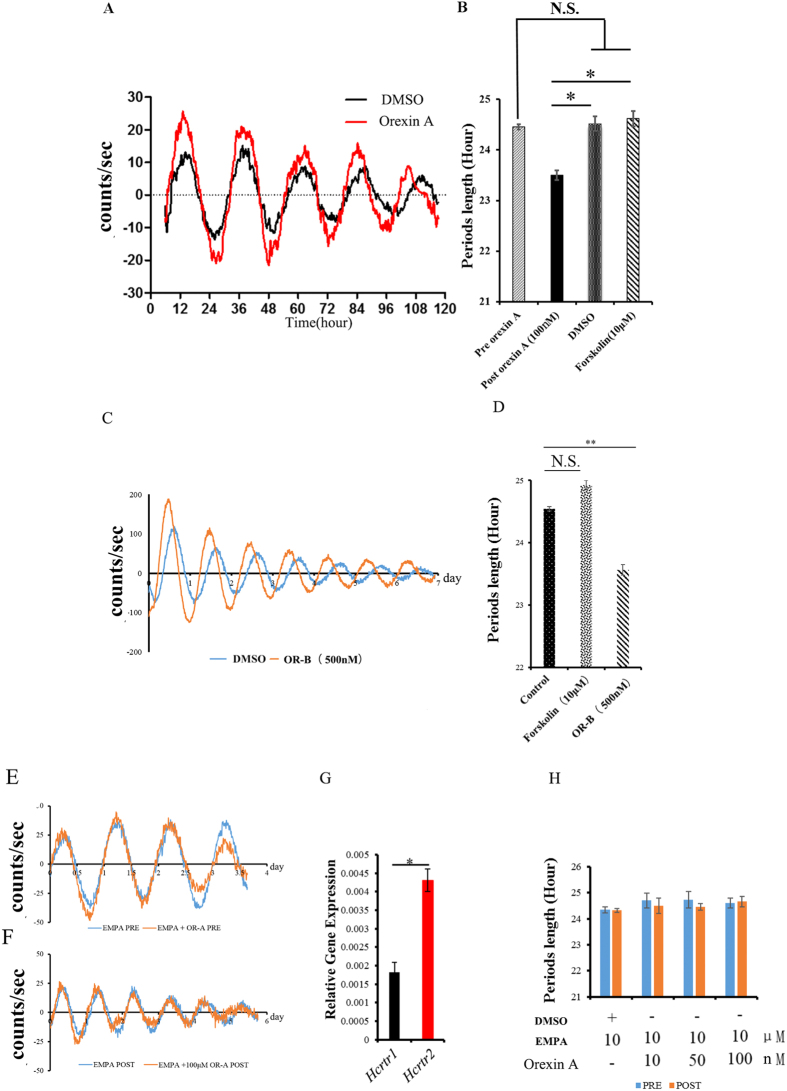
Orexin treatment led to shortening of the period of the hippocampal oscillator.(A) Effects of orexin A and DMSO treatments on hippocampal oscillation. (B) Orexin A treatment induced shortening of the period of the hippocampal oscillator as compared with the no-treatment control, the DMSO control, and the Forskolin (10 μM) treatment (n = 4–9); Bar graph (mean ± s.e.m.) of period; length of periods was analyzed by two-factor ANOVA, followed by Tukey’s HSD *P < 0.05. (C) Effects of orexin B and DMSO treatments on hippocampal oscillation. (D) Orexin B treatment induced shortening of the period of the hippocampal oscillator as compared with the DMSO control and the Forskolin (10 μM) treatment (n = 4–18); Bar graph (mean ± s.e.m.) of period; length of periods was analyzed by one-way ANOVA, followed by Tukey’s HSD *P < 0.05. (E,F,H,G) EMPA blocks the orexin A-induced shortening of the period of the hippocampal oscillator. The period showed no difference before EPMA and orexin A treatment. (E) EMPA blocks the orexin A-induced shortening of the period of the hippocampal oscillator. (F,G) Expression analysis of the orexin receptors shows that Hcrtr2 is the major receptor in the hippocampus.